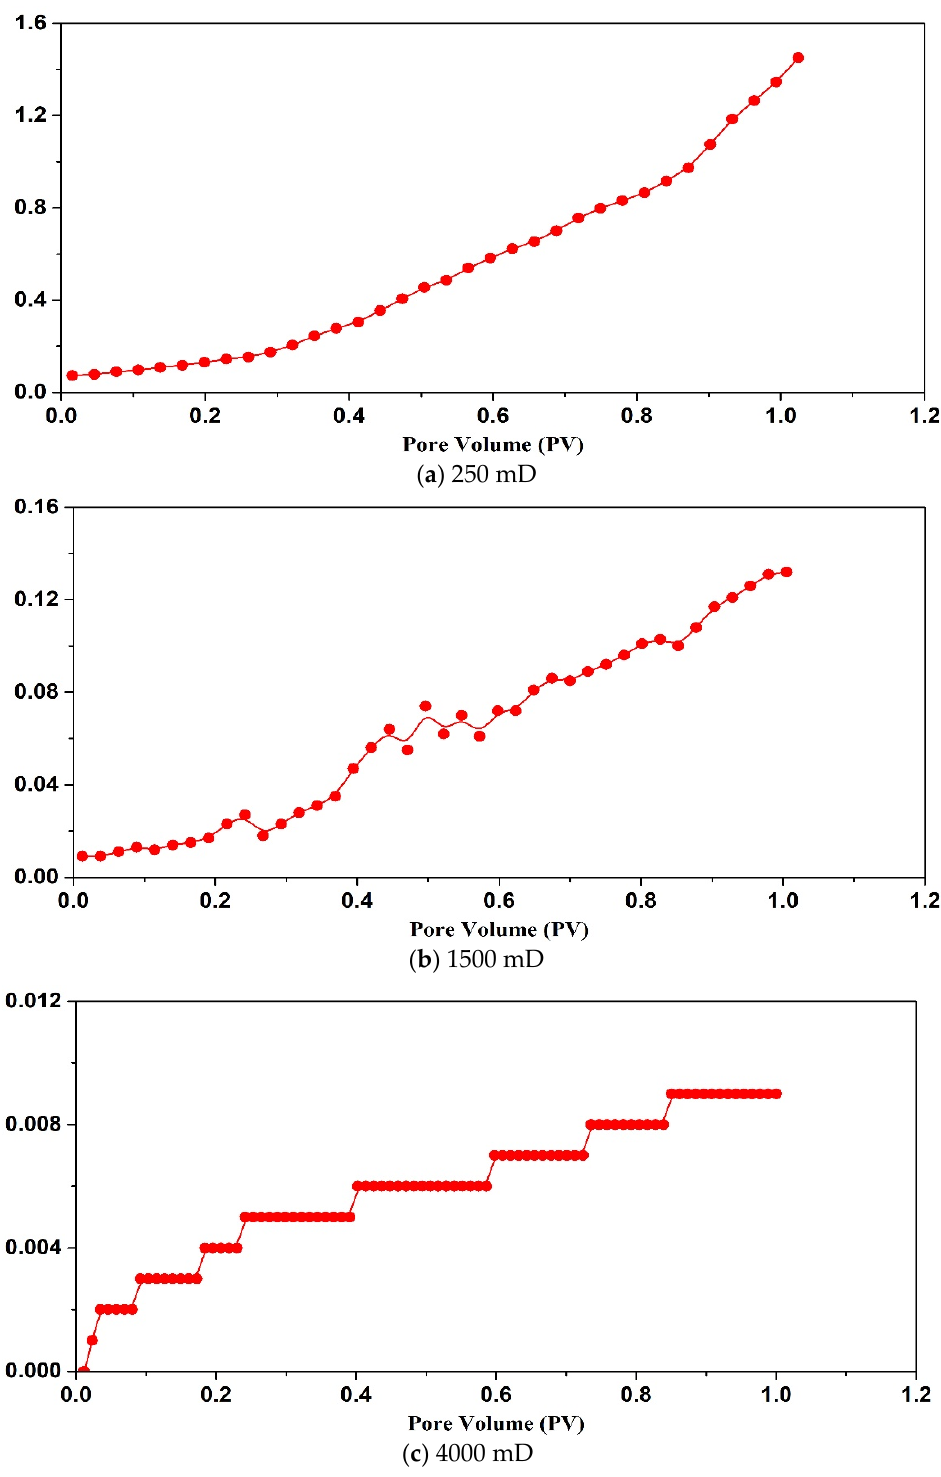
Figure 9. The pressure curve of the SMG-mm − aqueous dispersion injection stage.